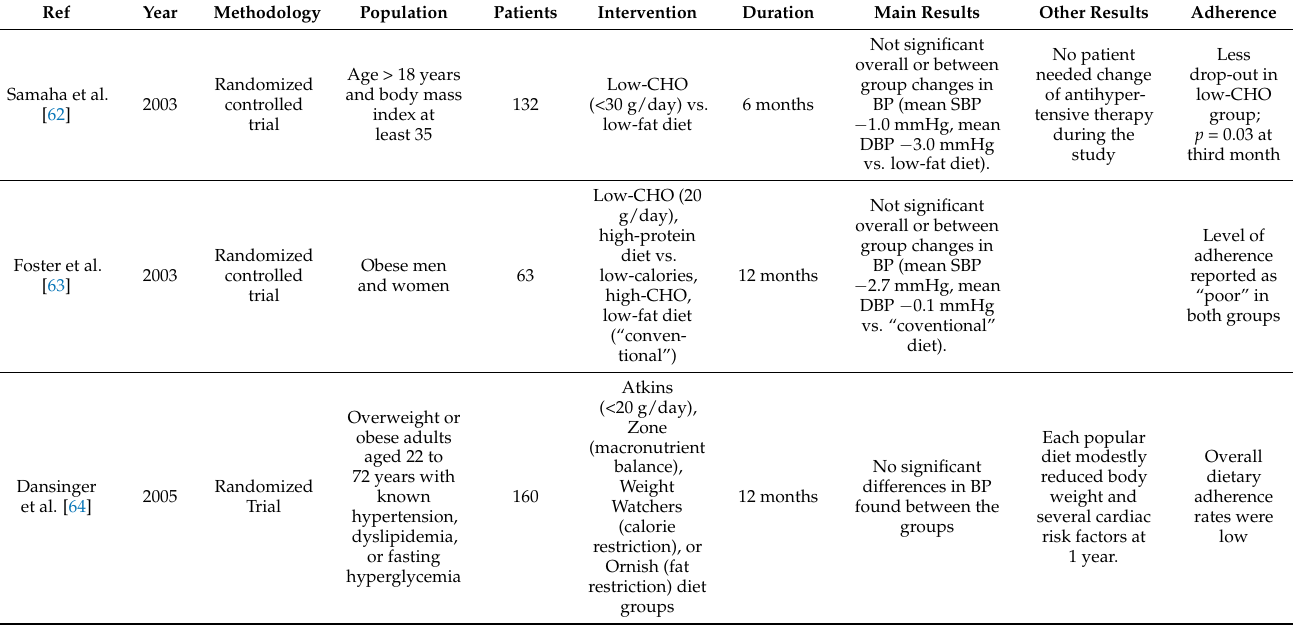
Table 1. Summary of studies addressing the effects of diets that supplied a daily intake of carbohydrates < 50 g on blood pressure